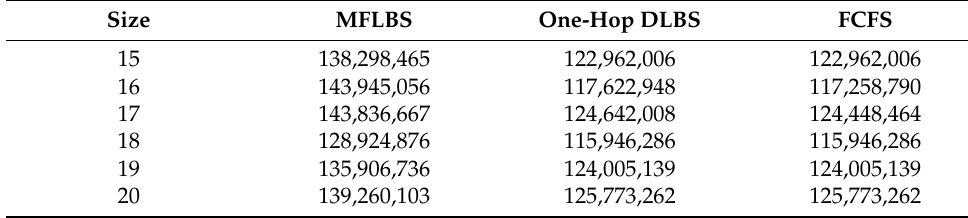
Figure 8. Three algorithms in mesh topology under semi-central pattern. Table 8. Average throughput (MB) in mesh topology under semi-central